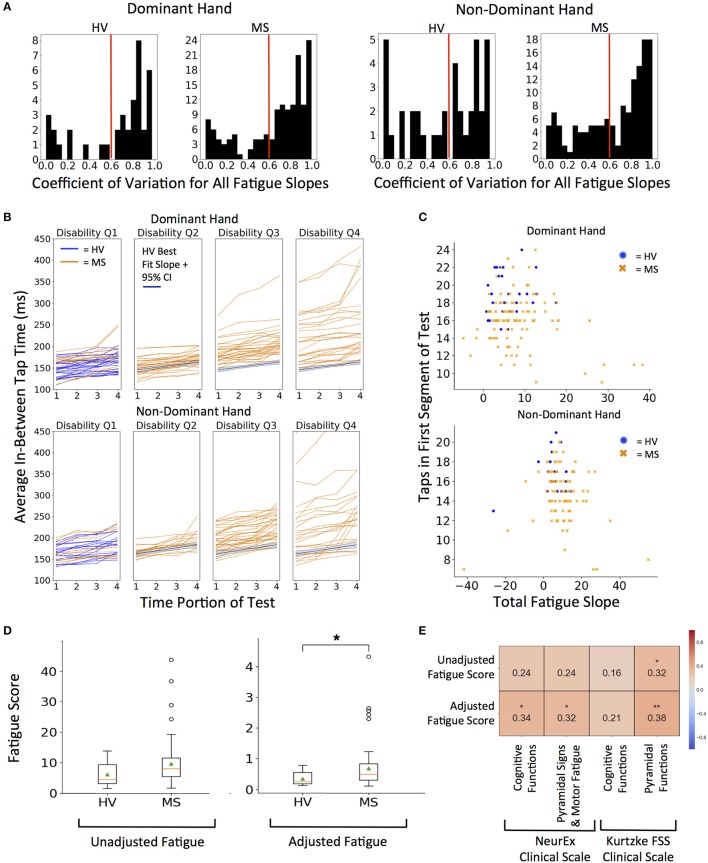
Quantifying fatigue through tapping. (A) Histograms for coefficient of variation for all fatigue slopes. Threshold of 0.6 R2 (marked with red line) was used as quality control for all future fatigue analysis. 0.8 R2 was used for sensitivity analysis in Supplementary Figures. (B) Distribution of fatigue slopes for HV (blue lines) and MS (orange lines) cohorts. MS patients are split into disability quartiles based on their total disability measured by NeurEx. The HV best fit fatigue slope with 95% confidence interval is overlaid in disability quartiles 2–4 for reference. (C) Fatigue Slope compared to starting taps to derive adjusted fatigue metric in HV (blue dots) and MS (orange dots) cohorts (D) Distribution of unadjusted and adjusted fatigue scores between cohorts. On each box plot, green triangles indicate the mean and orange lines indicate the median of depicted cohort datasets. Box plot box boundaries represent the Q1 to Q3 range centered about the median. Box plot whisker lengths extend to Q1–1.5 *IQR and Q3 + 1.5 *IQR. (E) Pearson correlations with corresponding clinical scores. Red to blue heat map represents value of the correlation coefficient ranging from 1 to −1, respectively. *p < 0.01, **p < 0.001.